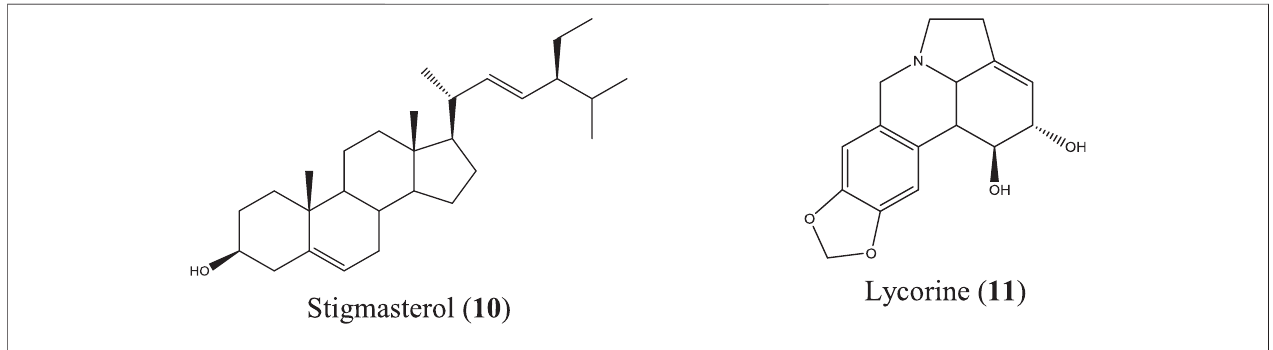
FIGURE 5 | Anti-in fl ammatory compounds isolated from C. asiaticum